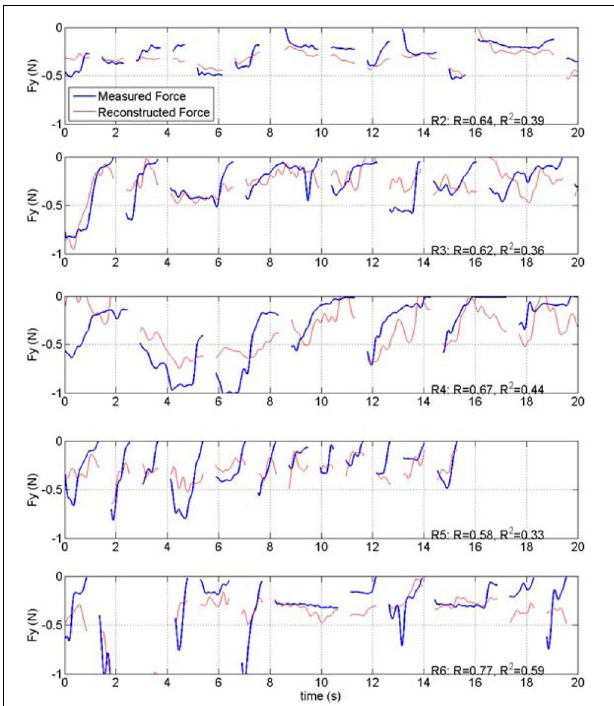
FIGURE 11 | Percent neural contributions to the vertical force ( Y ) in different frequency bands for the rats R2 through R6 (top to bottom). are composed of individual action potentials that have stereo- typical shapes, which implies similar frequency